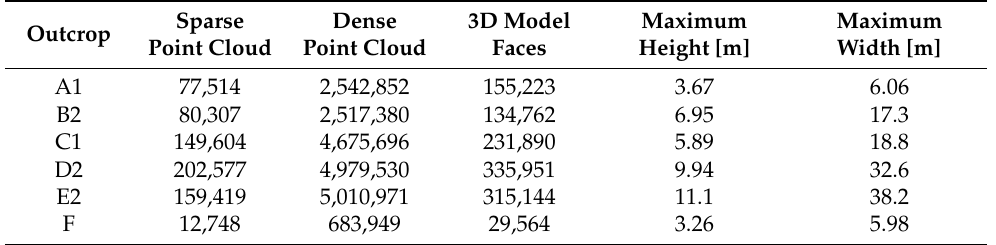
Figure 10. ( a – f ). 3D surface models (obtained from MP images) of selected outcrops from the six sectors forming the Flysch Sea cliff at Debeli Rtič . Table 7. Number of points forming the clouds and 3D models reconstructed using MP